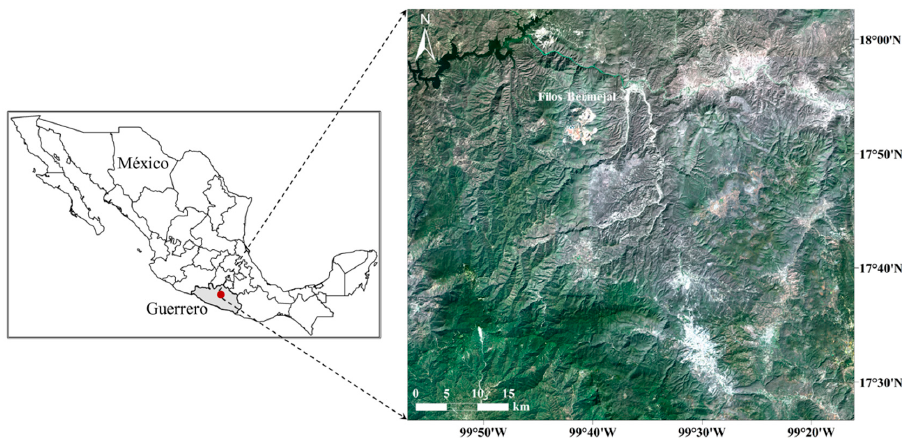
Figure 1. Mining zone “Filos-Bermejal” in Guerrero State, Mexico.